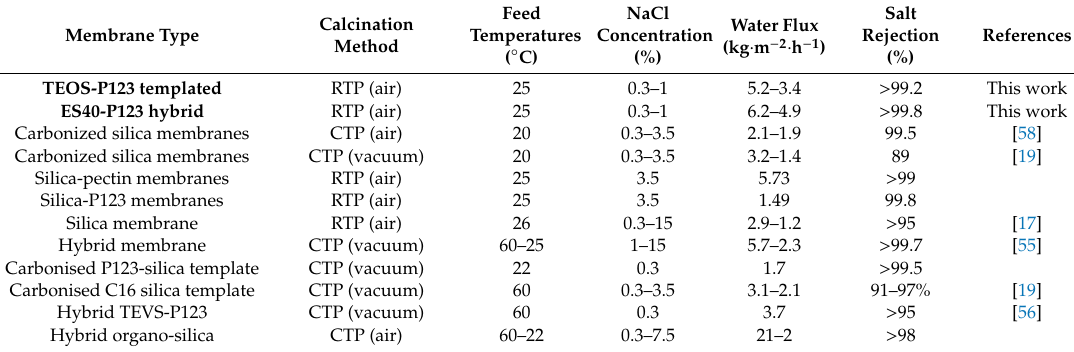
Figure 6. Schematic of P123 template silica (TEOS) and hybrid P123 (ES40) structure. Table 2. Summary of studies on silica membrane for